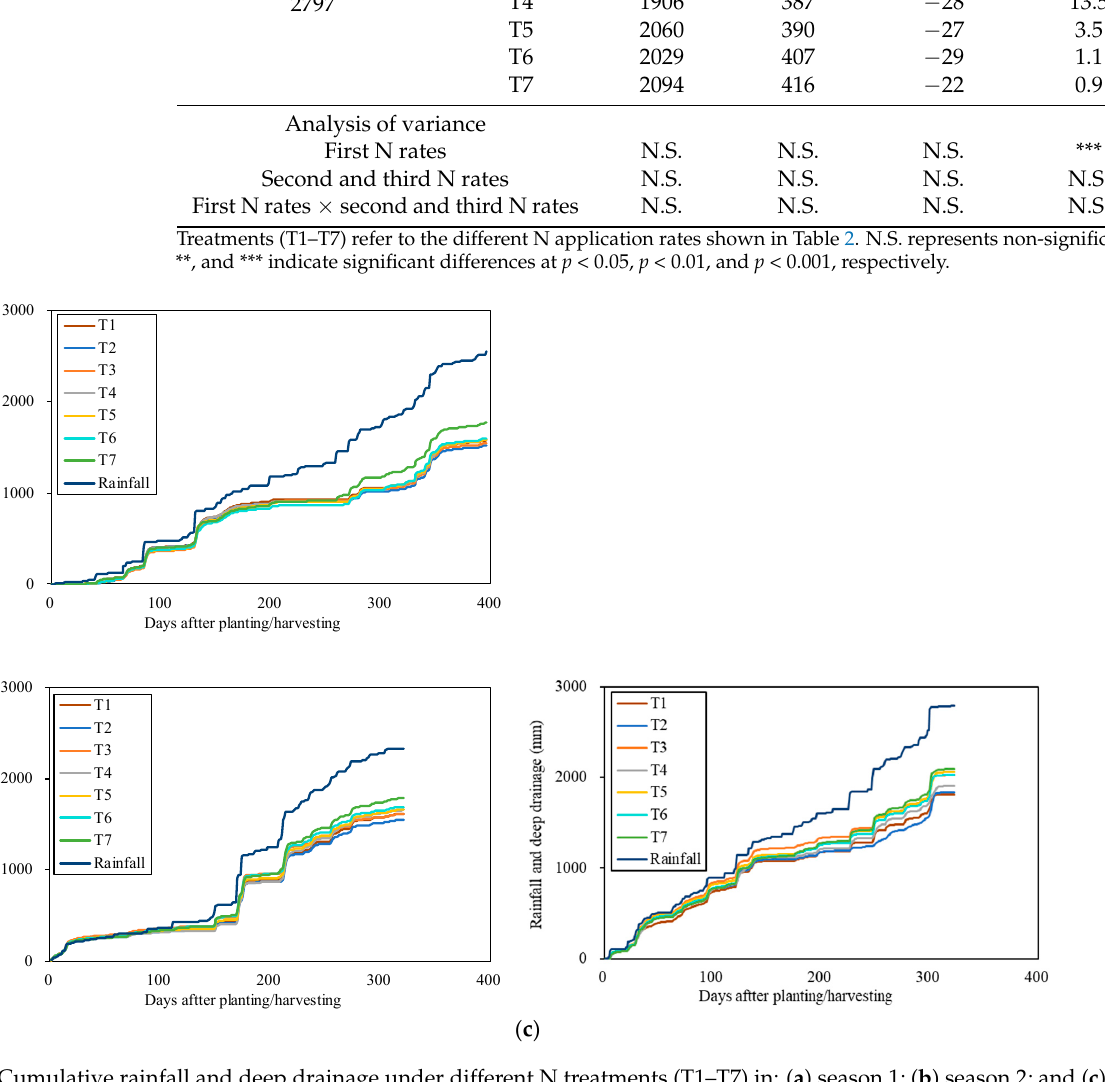
Figure 4. Cumulative rainfall and deep drainage under different N treatments (T1–T7) in: ( a ) season 1; ( b ) season 2; and ( c ) season 3. Treatments refer to the different N application rates shown in Table 2. The 2-m deep drainage for each treatment ranged from 1522 to 1769 mm in season 1, drainage water in T1–T6 were lower than those in the control treatment (T7) in all seasons. Significant differences in the infiltration water could not be detected by ANOVA among the different N fertilizer treatments during the three cropping seasons. However, in the medium-term (whole period), reductions in the second and third applications of N af- fected the infiltration rates (Table 6). During the entire period, deep drainage was syn- chronized with an increasing accumulated rainfall. Figure 4 shows that most of the rainfall drained into the deep layers, especially until the 3rd application. The differences in soil moisture in each treatment at the beginning and end of the cropping seasons were not largely affected by differences in the N fertilization rates over the whole period. Soil moisture decreased in season 1 ( − 63 to − 16 mm), increased in season 2 (18 to 33 mm), and decreased in season 3 ( − 35 to − 22 mm). These slight increases or decreases may have been caused by rainfall just prior to planting and harvesting. The soil moisture change in relation to total rainfall (7679 mm) ranged from 0.8 to 1.2% ( − 63 to − 16 mm). In short- and medium-terms, differences in N fertilizer application practices ap- peared to have little effect on changes in soil moisture, but had a significant impact on the amount of drainage of sugarcane fields. Table 6. Effects of reductions of the first, second, and third N fertilizer application rates on drain- age, initial soil water in the beginning of the season (initial SW), soil water change (SW change), and N load in the whole season. Rainfall and Fertilization Conditions